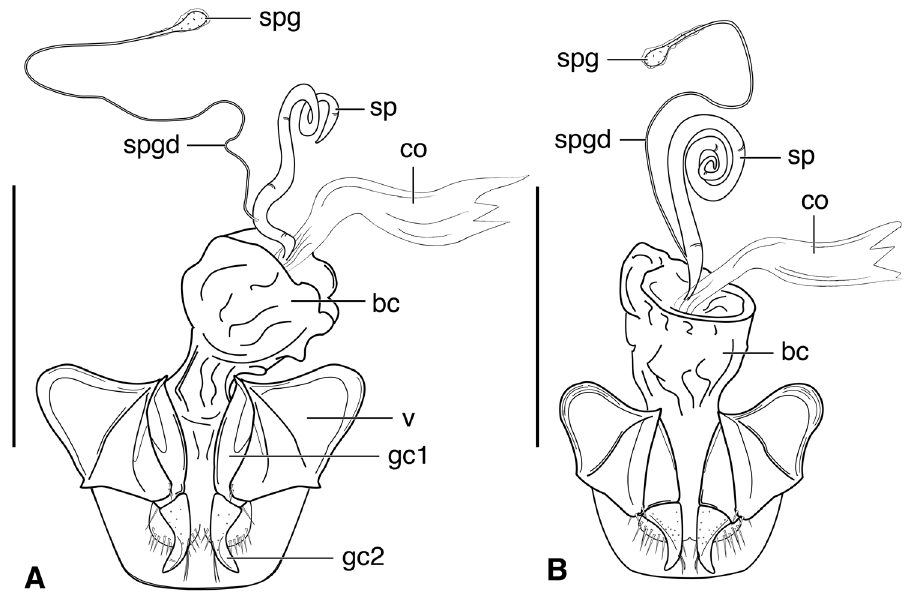
Figure 29. Line drawings of female reproductive tract of Selenophorus hylacis species group, in part, ventral aspect. A S. dessalinesi Ball & Shpeley B S. parvus Darlington. Legend: bc bursa copulatrix co common oviduct gc1 gonocoxite 1 gc2 gonocoxite 2 sp spermatheca sp1 spermatheca 1 sp2 spermatheca 2 spg spermathecal gland spgd spermathecal gland duct; v valvifer. Scale bars 1